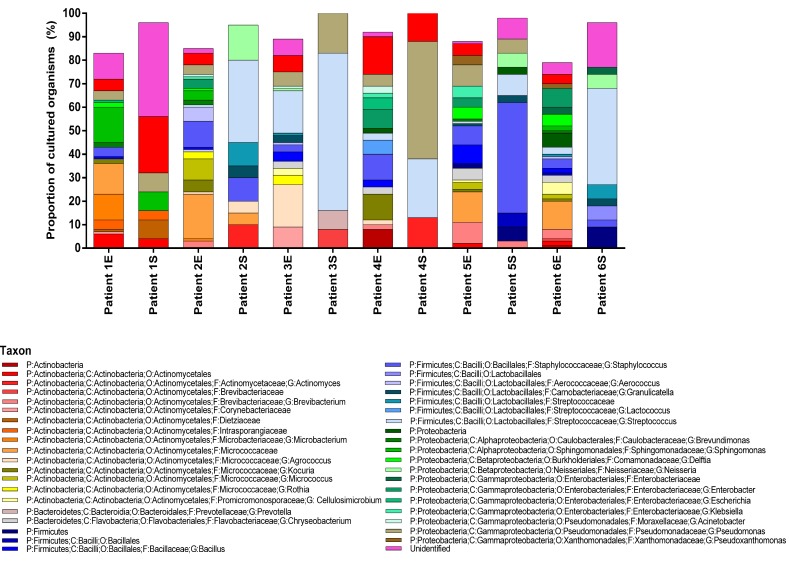
Cultured bacteria recovered from home environment represented as (Patient # 1–6) and source of isolate (S = sputum, E = environment) for all 6 patients.Legend shows a color representation of the taxonomic identification at the various taxonomic ranks from Sanger sequencing of the 16S rRNA DNA of the organisms. Organisms that were cultured in ≥ 6% of the total cultured organisms across all patients are included.